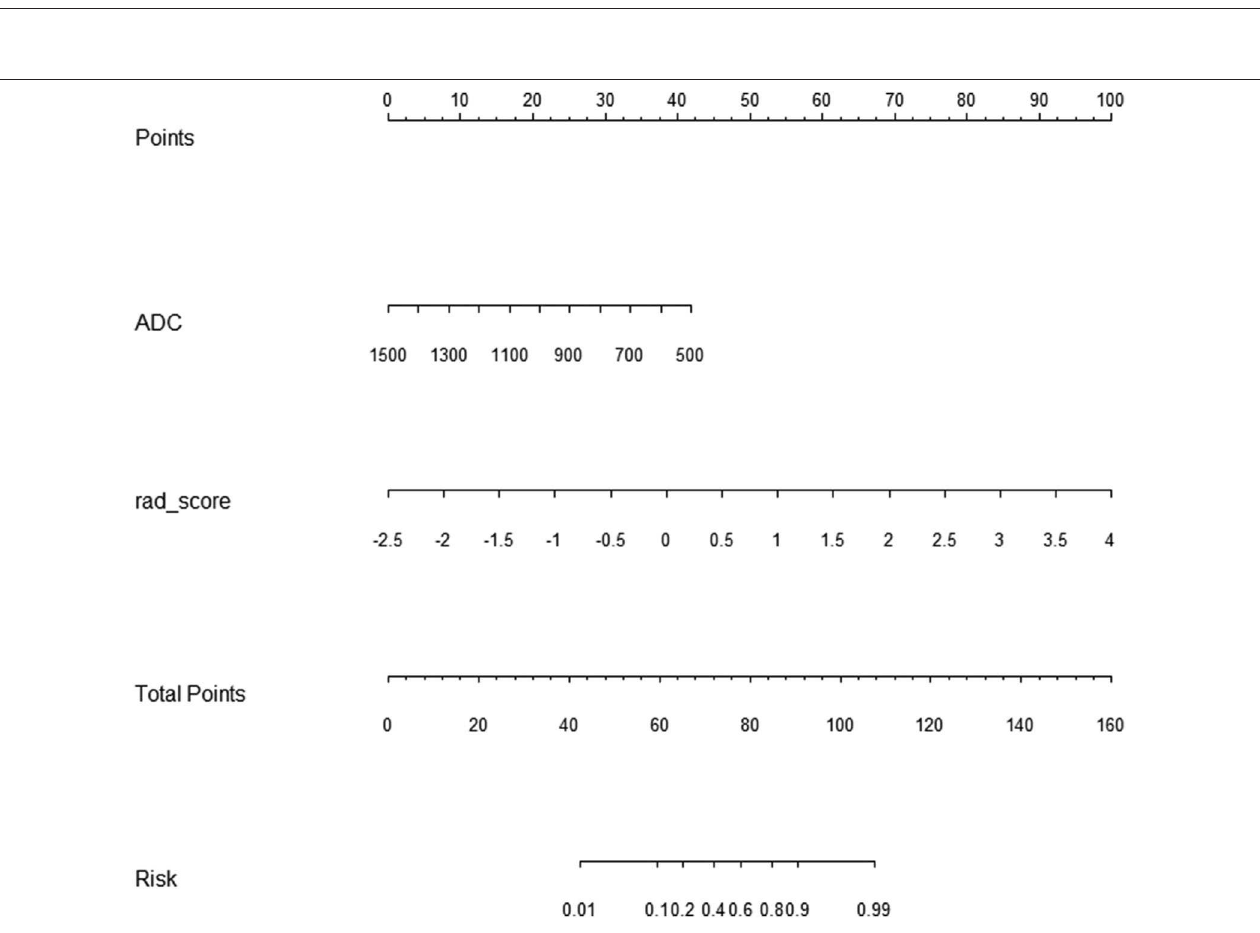
FIGURE 5 | Radiomic nomogram to discriminate clinically significant and clinically insignificant prostate cancer. The radiomic nomogram was built on the training group, with the rad-score and ADC value. For example, a 74-year-old prostate cancer patient with an ADC value of 800 × 10 − 6 s/mm 2 , its radiomic signature score was 2, the total number of points of this tumor was 100 (30 + 70), and the risk rate of clinically significant prostate cancer was determined to be 90%. ADC, apparent diffusion coefficient.